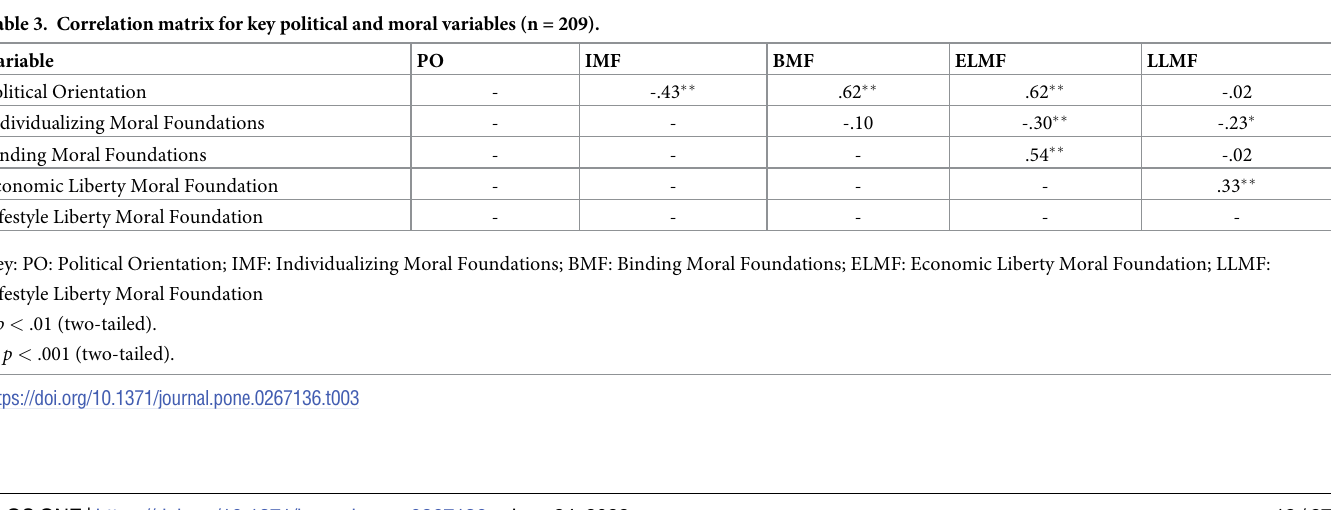
Overall, a more left-wing political orientation was significantly associated with more posi- tive and less negative social distancing attitudes, greater past compliance, greater future intended compliance, more moralization of compliance and public health, lower perceptions of government overreaction, and a greater prioritization of health over economic concerns. As predicted, this pattern of correlations each of the key outcome measures and valuation of both the binding and economic liberty foundations. Also as hypothesized, the opposite pattern of correlations was observed regarding valuation of the individualizing foundations. Further, as anticipated, endorsement of the lifestyle liberty items was not significantly correlated with any of the key outcome measures. These results also obtained largely across the two national sam- ples, as depicted in Tables 7 and 8. Overall, the pattern of significant correlations was consis- tent and in line with hypotheses 3 and 4. The exception to this was that individualizing foundations scores were significantly correlated with all of the social distancing outcome mea- sures in the U.S. sample, but, counter to hypothesis 3, only with the HVEP scale in the Cana- dian sample.